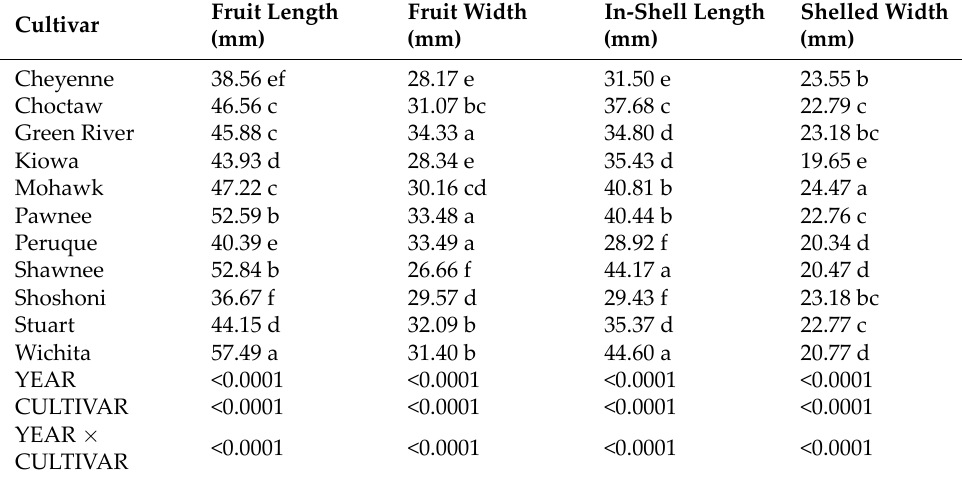
a Within each column means with different letters are significantly different according to the REGWQ test at p < 0.05.